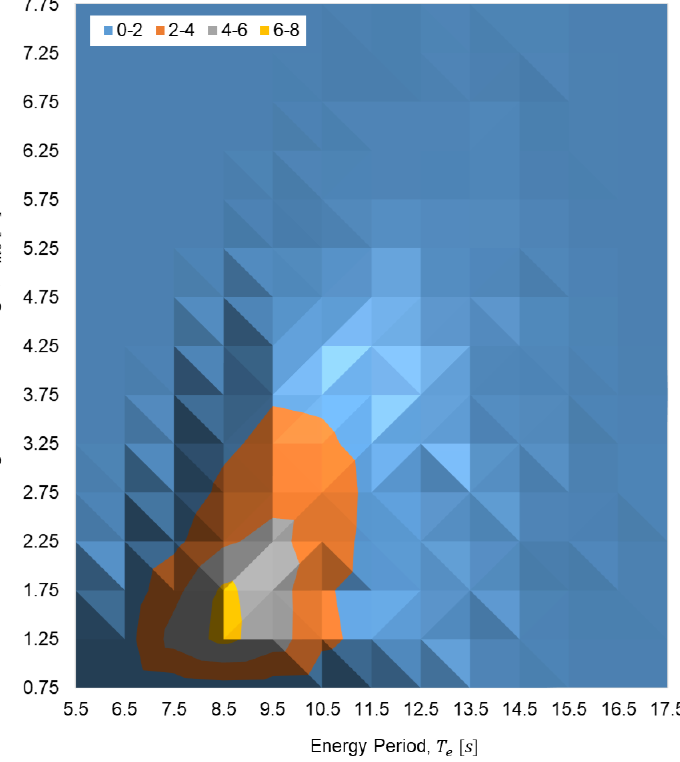
Figure 5. Annual wave probability distribution in the coastal waters near the City of Newport, Oregon (Data source: [36]).